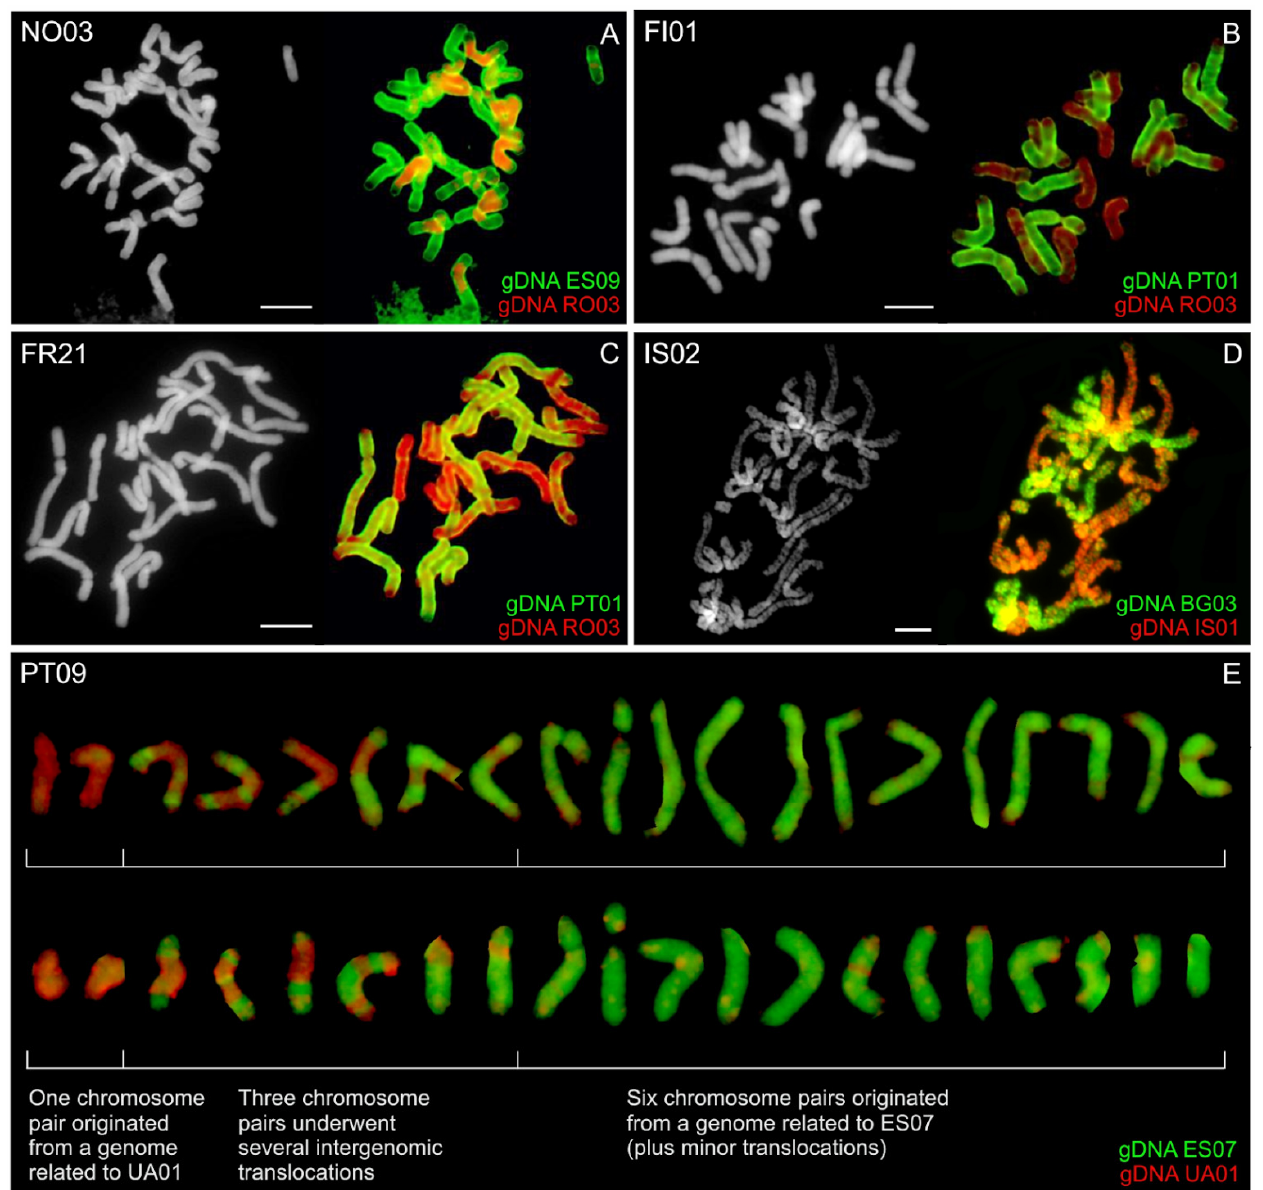
Figure 7. GISH in Anthoxanthum odoratum. Mitotic chromosomes of five selected population of A. odoratum (( A )—NO03, Norway; ( B )—FI01, Finland; ( C )—FR21, France; ( D )—IS02, Iceland; ( E )—PT09, Madeira–Portugal) were hybridized using gDNA of A. alpinum (RO03, IS01 or UA01, red fluorescence in ( A – E ) and A. aristatum/ovatum (ES09 or ES07; green fluorescence in ( A , E )), A. maderense (PT01; green fluorescence in ( B , C )) and “Mediterranean diploid” (BG03, green fluorescence in ( D )). Chromosomes were counterstained with DAPI. Scale bars, 10 µm.